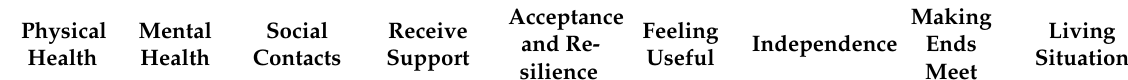
Table 2. Spearman correlations among WOOP items, n = 353.